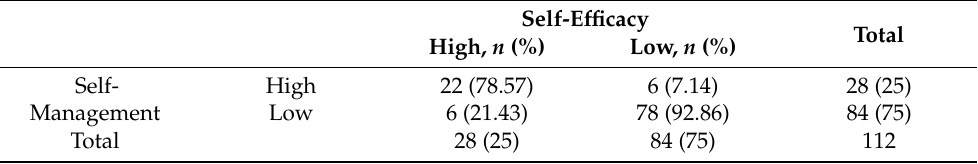
Table 1. Distribution of high self-management and -efficacy in the study participants.